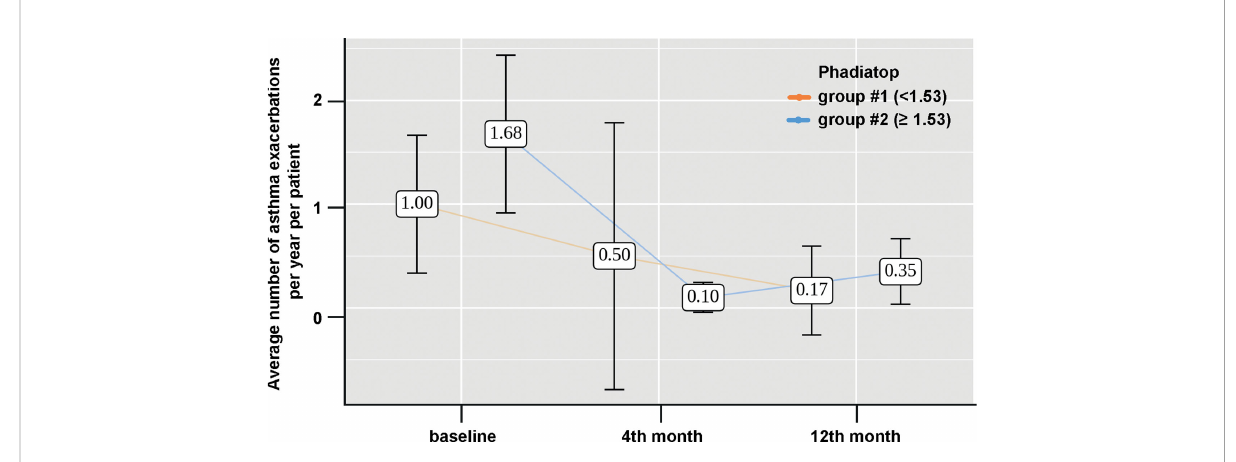
FIGURE 4 Changes of the number of asthma exacerbations during Omalizumab therapy depending on the initial value of the Phadiatop ™ test (Group 1, < 1.53 PAU/l light brown and group 2, > 1.53 PAU/l